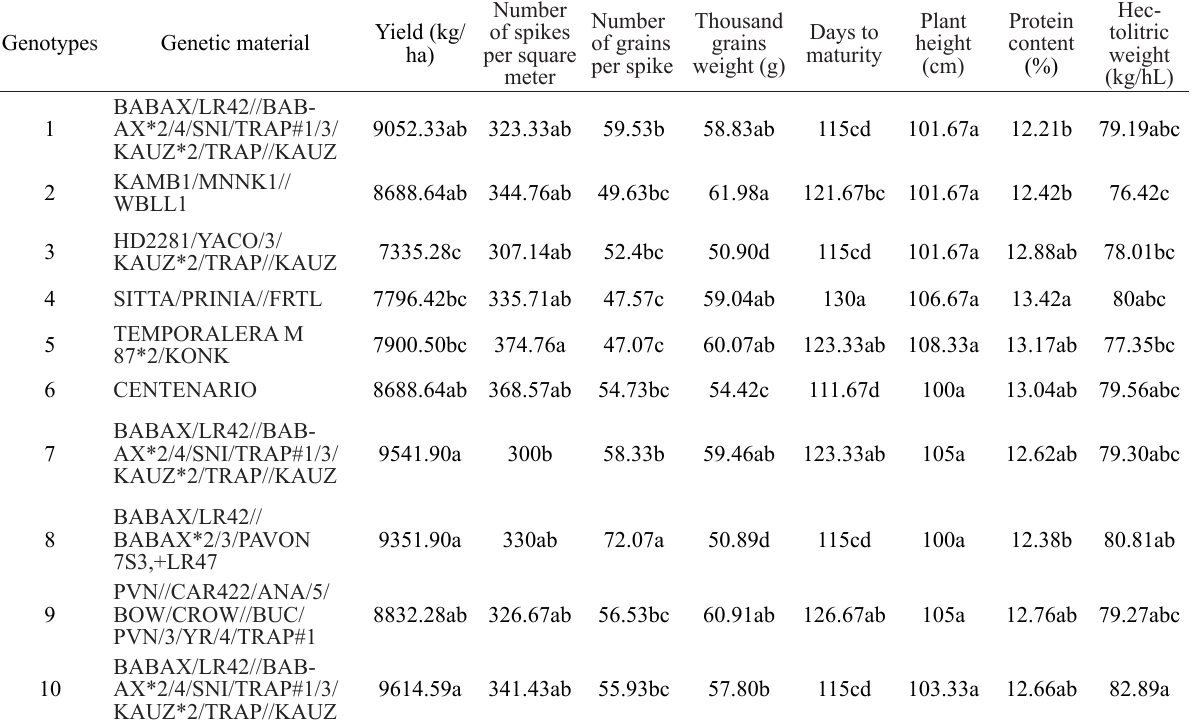
Table 4. Mean values of grain yield, number of spikes per square meter, number of grains per spike, thousand grains weight (g), days to maturity, plant height (cm), grain protein (%) and hectolitric weight of the control experiments of the assessment of tolerant wheat genotypes ( Triticum aestivum L ) to Drought under Conditions of La Molina LM